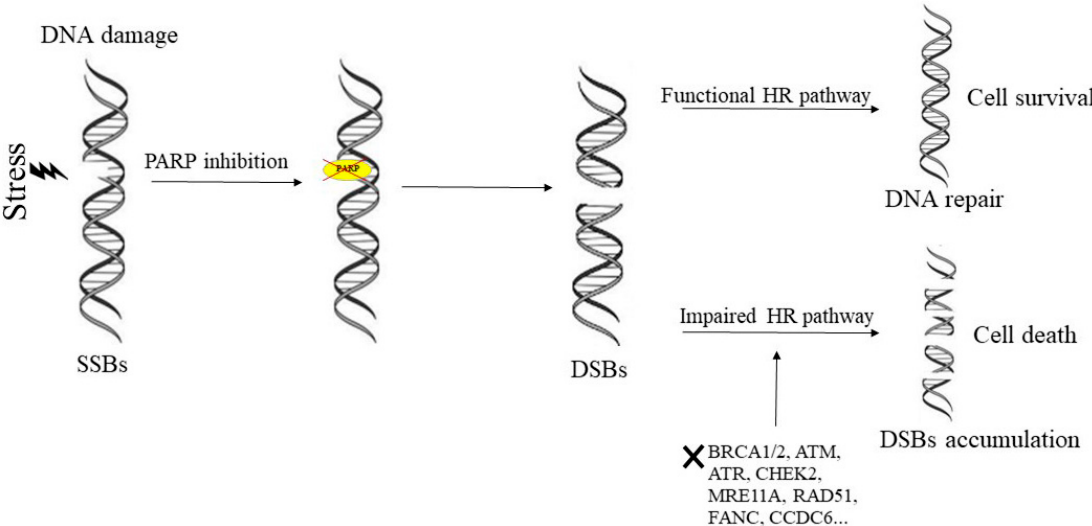
Figure 1. Synthetic lethality of PARP-inhibitors in HR-deficient tumors. Several stress can generate the single strand breaks (SSBs) that are repaired by poly(ADP-ribose) polymerases (PARPs) through the BER pathway. PARP inhibition prevent the repair of SSBs, resulting in the generation of double strand breaks (DSBs). The DSBs are repaired in cells through the functional HR-mediated DNA repair pathway, but in the presence of impaired HR pathway the DSBs cannot be effectively repaired resulting in DSB accumulation, genomic instability, and cell death.